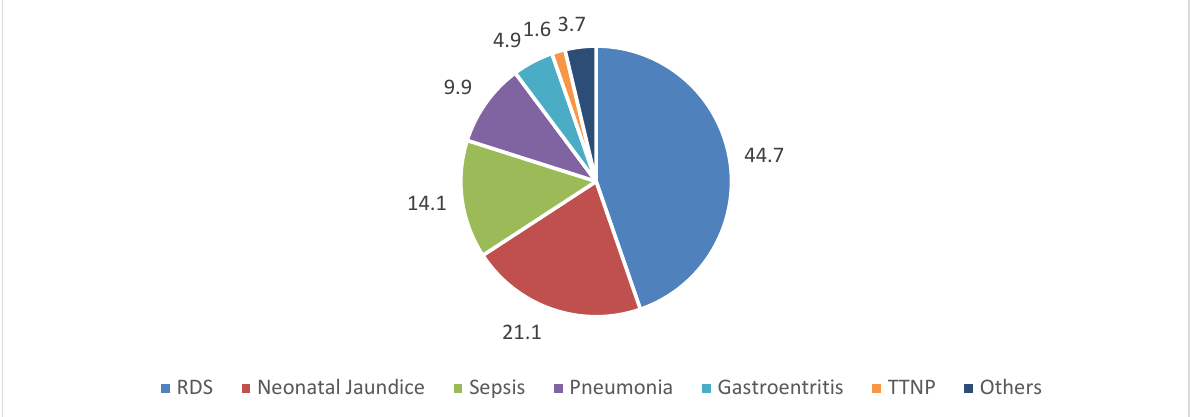
Figure 11: Indication for antibiotics in NNCU (Total